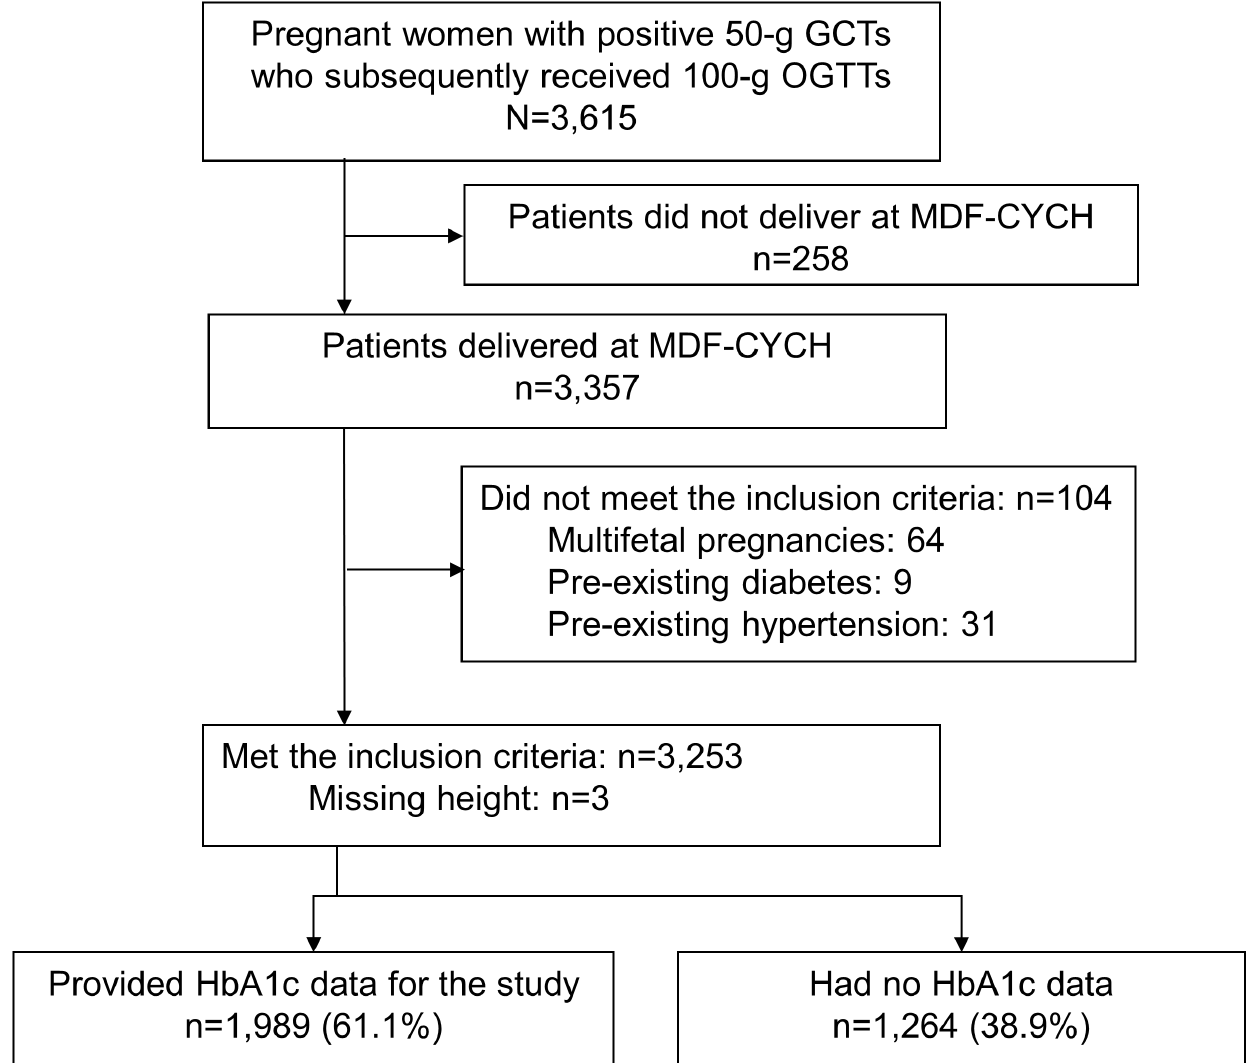
Fig 1. Enrollment of study subjects. GCT, glucosechallenge test; OGTT, oral glucosetolerance test; DMF-CYCH, Ditmanson Medical Foundation Chia-Yi ChristianHospital; HbA1c, hemoglobin A1c.